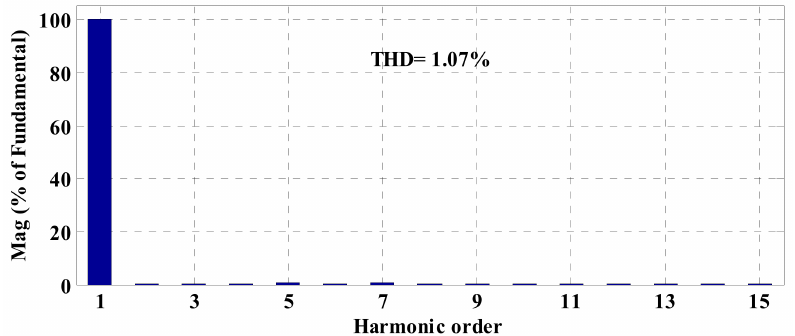
Figure 13. THD spectra of the injected current of DG1 based on the proposed control strategy.